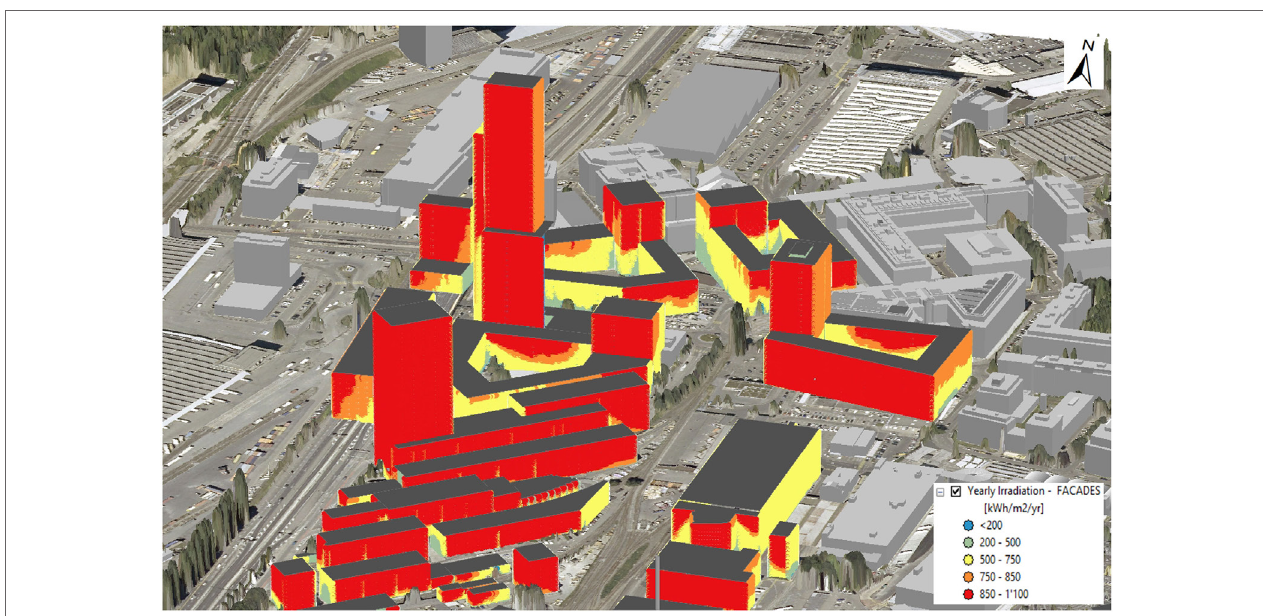
FIGURe 10 | 3D representation of the solar radiation outputs (intensity in kWh/m 2 /year) on building facades in a sector of the Municipality of Carouge, mixing new tall building developments and existing industrial areas.